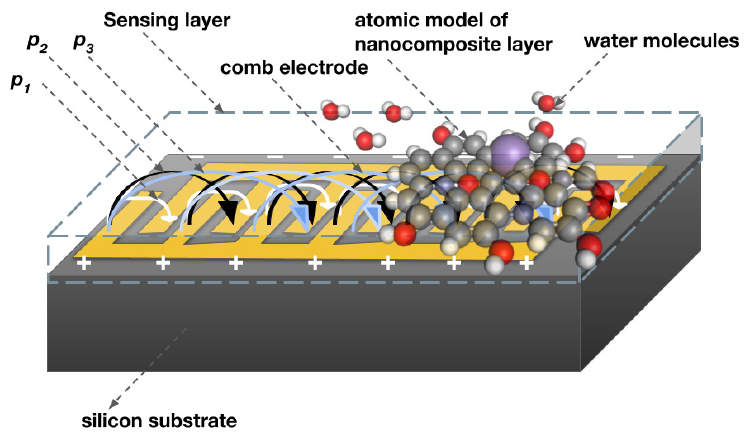
Figure 14. The fringing electric field in IDE of different pitch lengths p 1, p 2, and p 3 illustrates the penetration depth over the sensing layer.